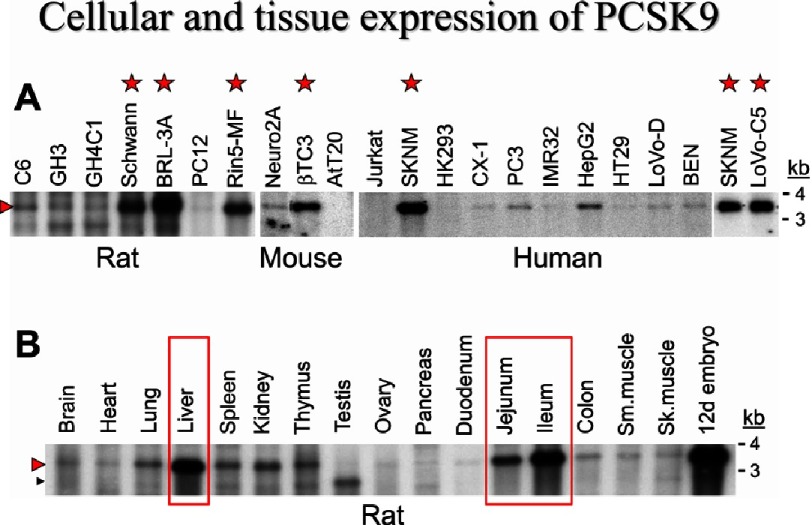
Cellular and tissue expression of PCSK9.Northern blot analysis of PCSK9 mRNA in 21 rat, mouse, and human cell lines (A) and 17 rat tissues (B) (Sm, smooth; Sk, skeletal; d, day). The open arrow points to the smaller testicular mRNA. The red stars denote high expression of PCSK9 in specific tumor derived cell lines. The tissues expressing high levels of PCSK9 are boxed in. Modified from.5.